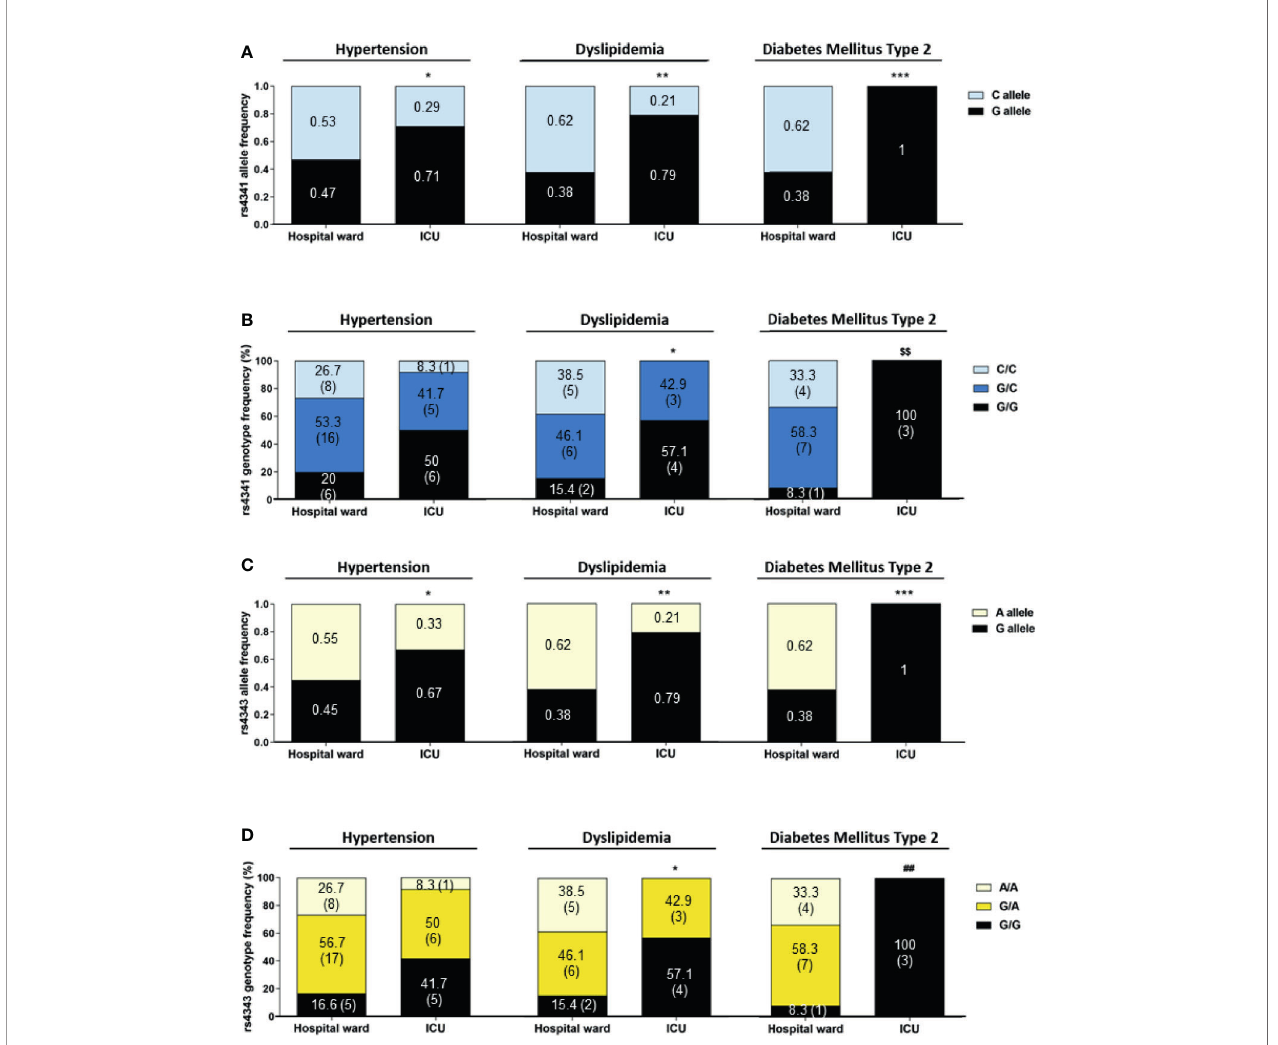
FIGURE 3 | Allelic and genotypic frequencies of rs4341 and rs4343 polymorphisms in COVID-19 patients according to its hypertensive, dyslipidemic or diabetic status. Allele frequencies of rs4341 (A) and rs4343 (C) polymorphisms. Data are presented as proportions. * p < 0.05, ** p < 0.01, *** p < 0.001 vs Hospital ward. Genotype frequencies of rs4341 (B) and rs4343 (D) polymorphisms. Data are presented as percentages. The number of patients is indicated in brackets. * p < 0.05 vs Hospital ward group for G carriers (GG+GC vs CC and GG+GA vs AA). $$ p < 0.01 vs Hospital ward between GG and GC and CC, GG+GC and CC, GG and GC+CC. ## p < 0.01 vs Hospital ward between GG and GA and AA, GG+GA and AA, GG and GA+AA. All data were adjusted for age and